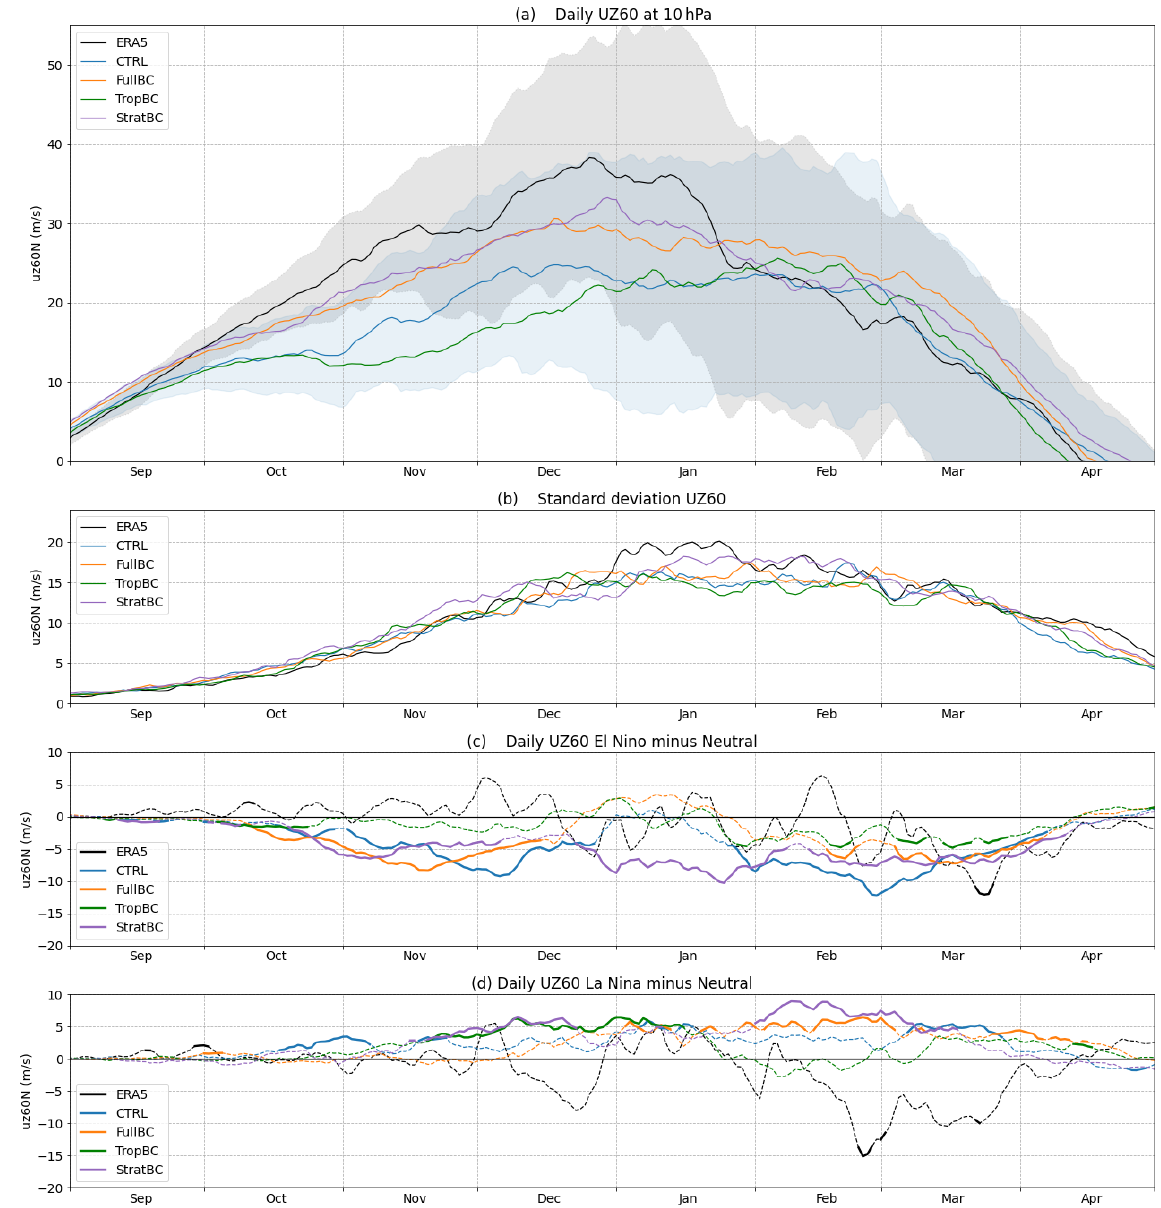
Figure 1. (a) Mean daily zonal mean zonal winds at 60 ◦ N and 10hPa for ERA5 (1979–2019) and control and bias correction experiments (100 years each). Shading shows 1 standard deviation for ERA5 (grey) and CTRL (blue). (b) Mean daily standard deviation for ERA5 and the experiments. (c) Daily uz 60 El Niño response calculated as El Niño years minus neutral years, e.g. CTRL_EN – CTRL. (d) Daily uz 60 La Niña response calculated as La Niña years minus neutral years. For (c) and (d) the dashed line shows the mean El Niño and La Niña response, and a solid line indicates responses significant at the 5%